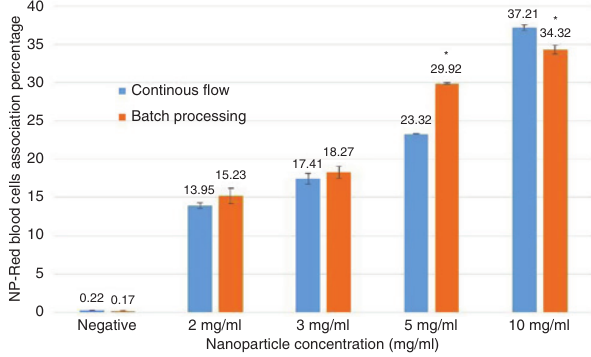
Figure 3: FACS analysis of nanoparticles associated with RBCs exposed to increasing concentrations of continuous flow and batch processing synthesized nanoparticles. Untreated blood sample was used as the negative control. *Significant difference between two samples at same concentration (p-value < 0.05). Data are presented as means ± SD, n =